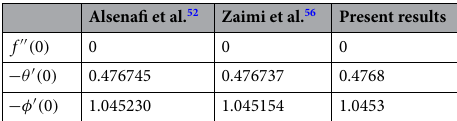
Table 1. The comparative outputs.